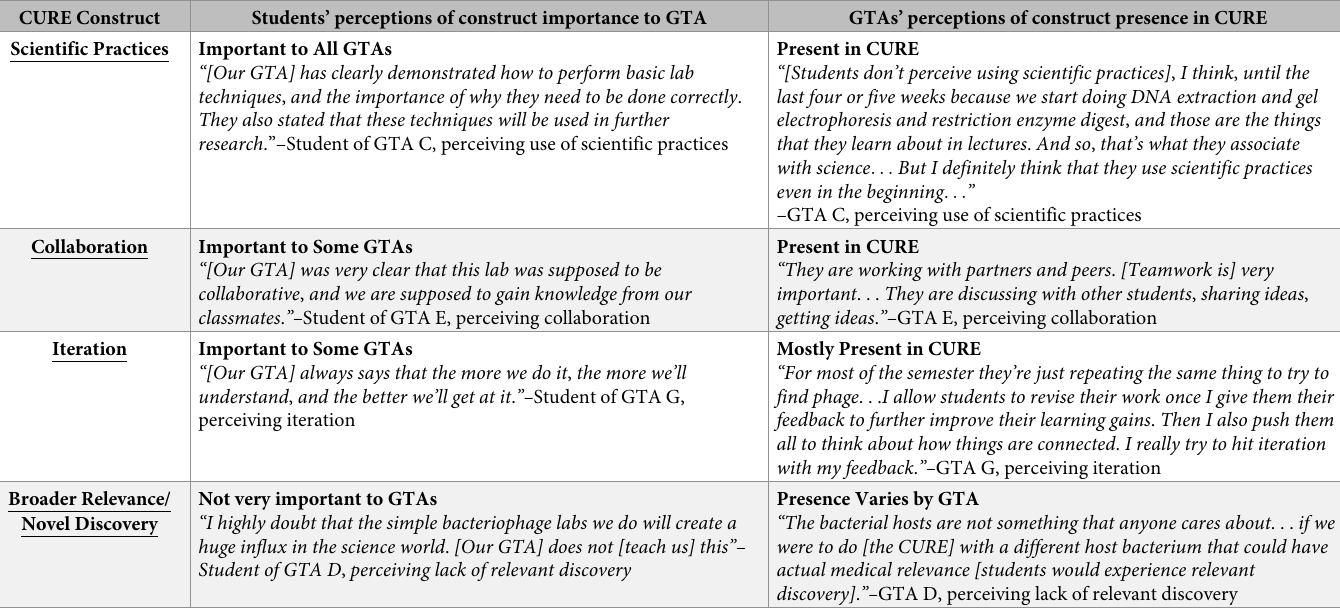
Table 3. Alignment of student and GTA perceptions of the importance of individual CURE constructs �